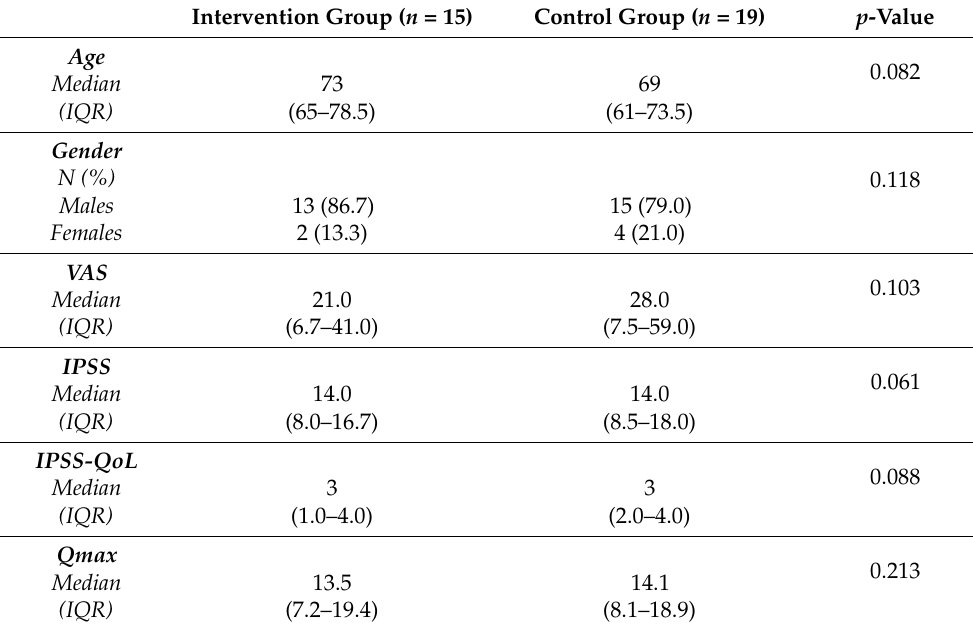
Figure 1. Consort 2010 Flow Diagram. Table 1. Baseline characteristics of the patients.